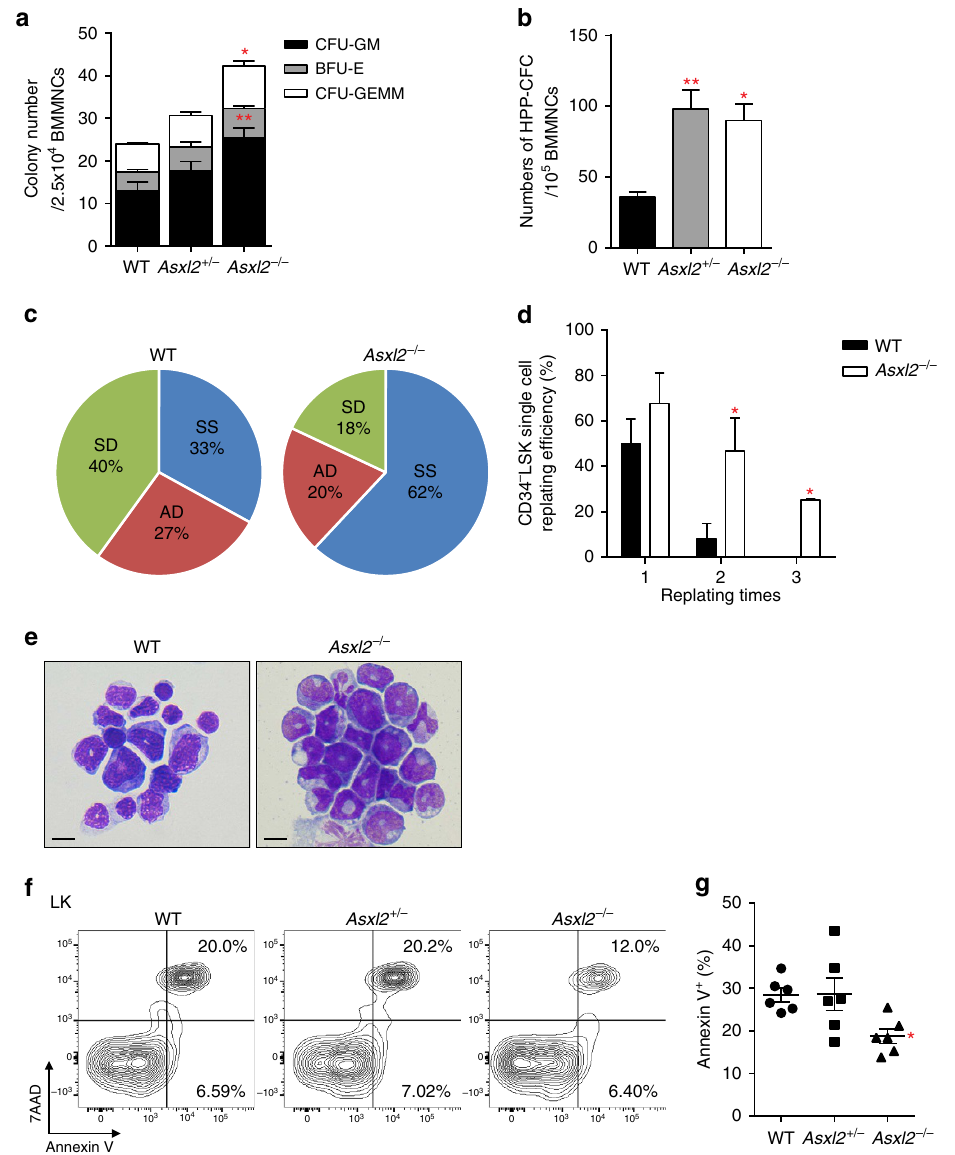
Figure 3 | Loss of Asxl2 alters HSC self-renewal and cell fates. ( a ) CFUs in BM cells from WT, Asxl2 þ / (cid:2) and Asxl2 (cid:2) / (cid:2) mice (6–8 week old, three mice per genotype) were assessed in semi-solid media in the presence of mouse (m) SCF, mIL-3, human (h) IL-6, mTPO, mouse granulocyte–macrophage colony-stimulating factor (mGM-CSF) and mEPO. BFU-E, burst forming unit-erythrocyte; GEMM, mixed colonies of GM, E, and megakaryocytic cells; GM, granulocytes/macrophages. BMMNCs, bone marrow mononuclear cells. ( b ) HPP-CFC were determined in the BM of WT, Asxl2 þ / (cid:2) and Asxl2 (cid:2) / (cid:2) mice (6–8 week old, three mice per genotype) in the presence of mSCF, human IL6 (hIL-6), hFlt3L, mIL-3, mGM-CSF and mG-CSF. The quantification of large colonies ( Z 1mm) was enumerated on the 14th day of cultures. ( c ) Paired daughter cell assays were performed at single cell level on CD34 (cid:2) LSK cells isolated from WT and Asxl2 (cid:2) / (cid:2) mice, and each analysed for symmetric self-renewal (SS, blue), asymmetric cell division (AD, red) or symmetric differentiation (SD, green). ( d ) Single-cell replating assays on the CD34 (cid:2) LSK cells isolated from WT and Asxl2 (cid:2) / (cid:2) mice were performed to determine replating capacity (6–8 week old, three mice per genotype). ( e ) Representative images of May–Gru¨nwald–Giemsa-stained cytospin preparations of cells derived from WT and Asxl2 (cid:2) / (cid:2) CD34 (cid:2) LSK cell cultures. Scale bar, 10 m m. ( f ) Apoptosis analysis (Annexin V/7-AAD staining) on freshly isolated Lin (cid:2) cKit þ (LK) cells from BM of representative WT, Asxl2 þ / (cid:2) and Asxl2 (cid:2) / (cid:2) mice. ( g ) Quantification of the apoptotic cells (Annexin V þ ) within LK cells of BM from WT, Asxl2 þ / (cid:2) and Asxl2 (cid:2) / (cid:2) mice (6–8 week old, six mice per genotype). The colony assay was performed in three replicates. Data are presented as mean ± s.e.m. Comparisons among more than two groups were performed by one-way analysis of variance test. Comparisons between two experimental groups were performed by two-tailed unpaired Student’s t -test. * P o 0.05 and ** P o